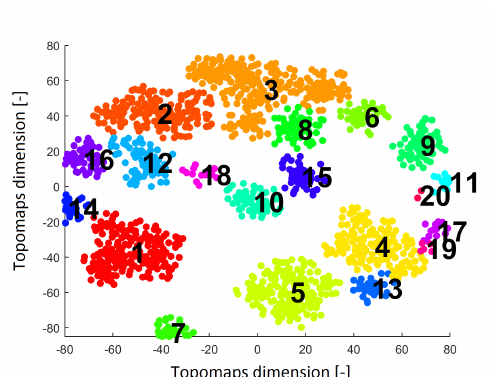
Figure 5. Result after applying the clustering algorithm Density-based spatial clustering of applications with noise (DBSCAN) to the IC space resulting from the t-SNE method with a perplexity of 30. The result shows 20 clusters (each cluster is labeled by a number and is a different color).